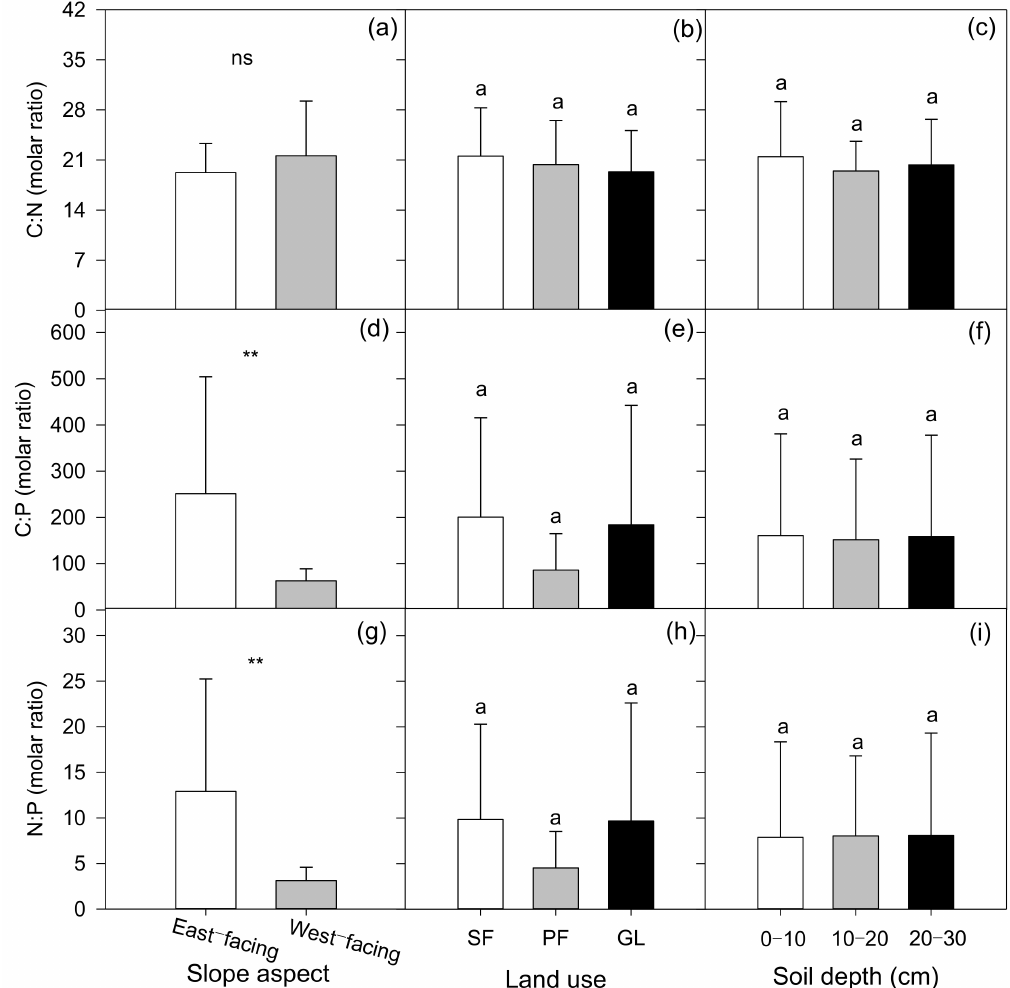
Figure 3. Soil C:N ( a – c ), C:P ( d – f ), and N:P ( g – i ) ratios affected by slope aspect, land use and soil depth, respectively. Error bars represent standard deviation of means. “**” marked in the middle indicates significant difference between slope aspects. “ns” represents no significance. Same lowercase letters denote no significant difference among land uses and soil depths, respectively. SF, secondary forest; PF, plantation forest; GL,